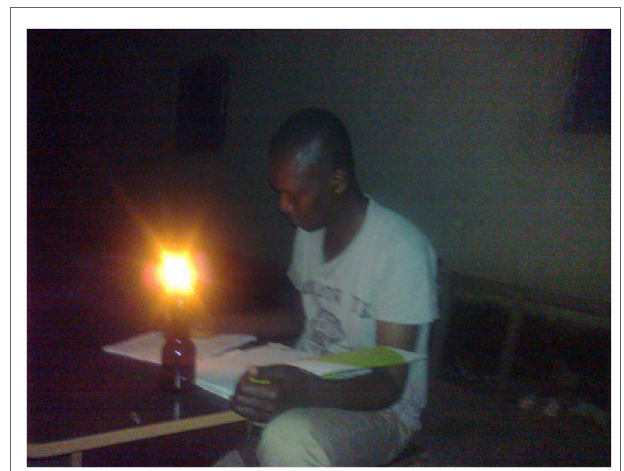
FigUre 1 | a student studying with kerosene lamp at night